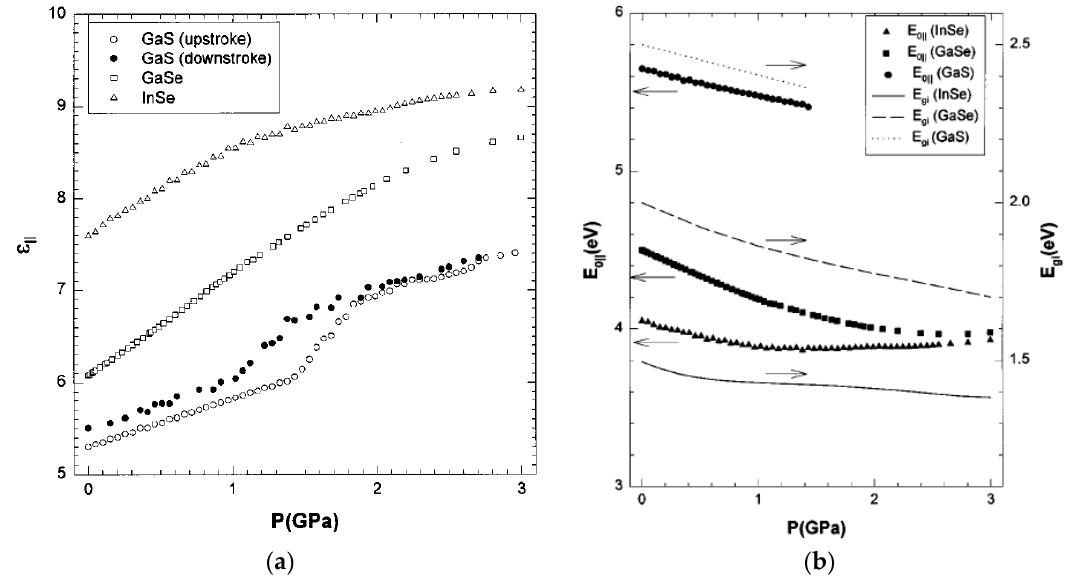
Figure 19. ( a ) Pressure dependence of the static dielectric constant ε 0 (cid:107) for β -GaS, ε -GaSe, and γ -InSe [87]. ( b ) Correlation between the pressure behavior of the Penn gap E 0 (cid:107) and the indirect gap in the three compounds [87].